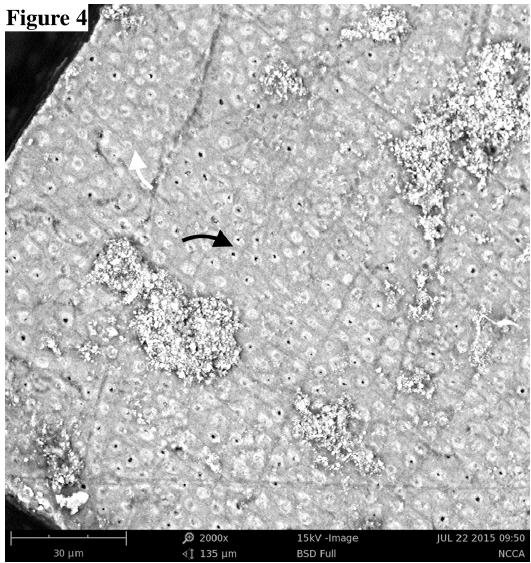
Figure 2 – (Magnification: 2000x – Scale bar: 30µm) - Representative SEM image of fractured specimen from Multilink group (dentin side). Note the difference between the aspect of dentin surface (black arrows), poor sign of demineralization could be detected and the layer of resin cement (white arrow).